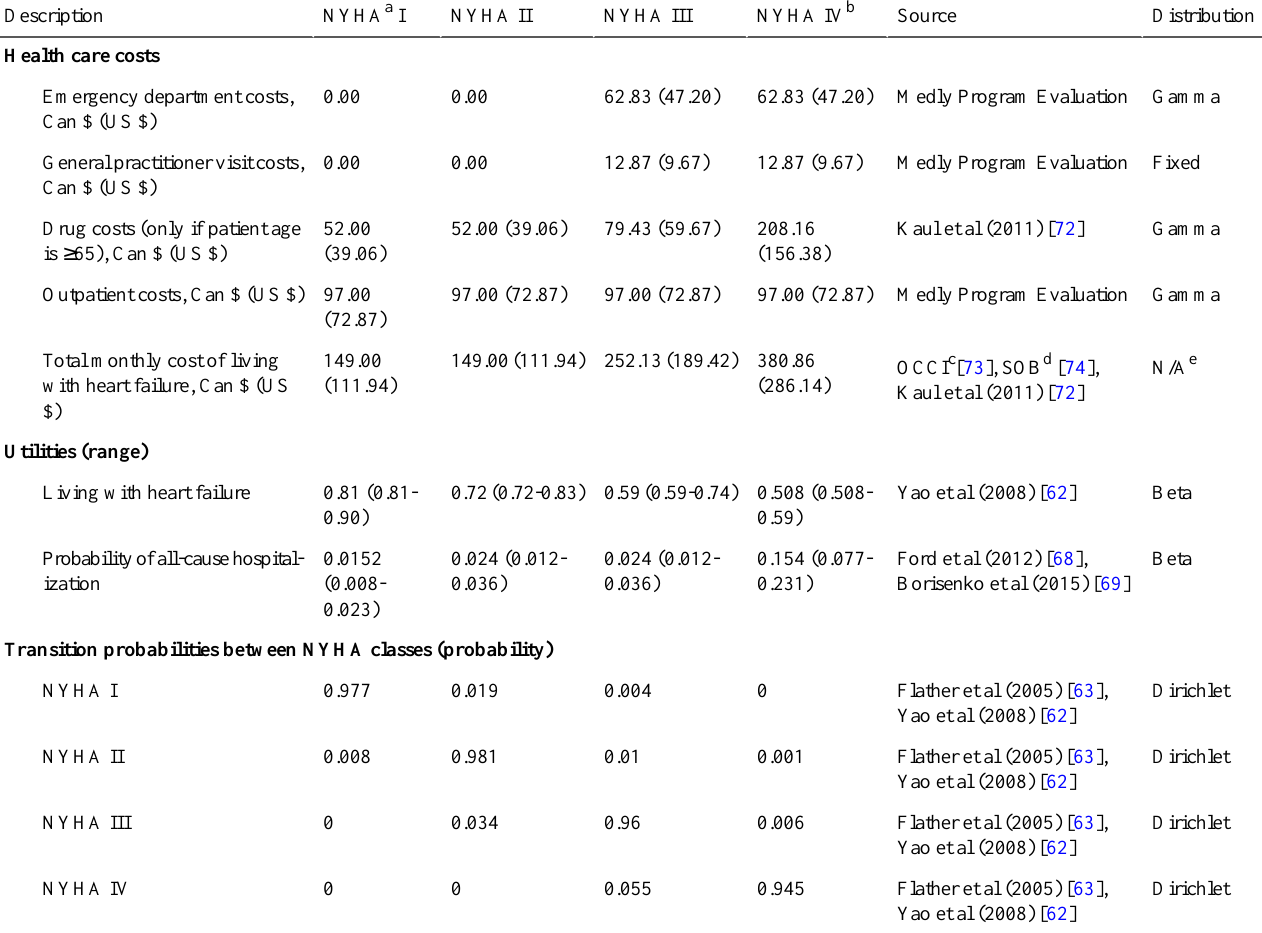
Table 2. Model parameters conditional on New York Health Association (NYHA) class including living with heart failure costs (in Can currency), utilities, probability of hospitalization, and transitions between NYHA